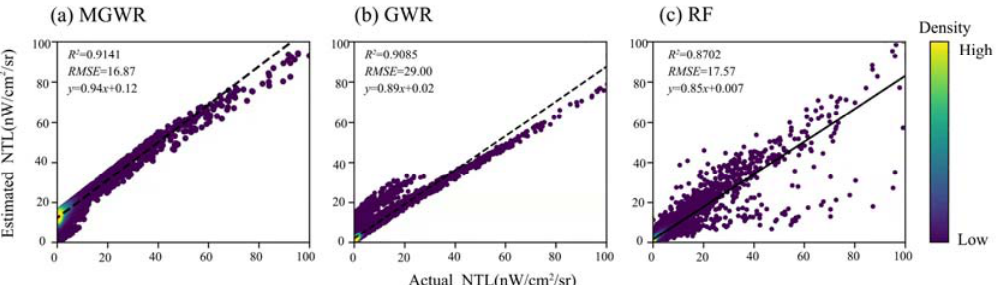
Figure 3. Scatter density plots between the estimated and actual NTL values for each pixel between ( a ) MGWR, ( b ) GWR, and the ( c ) RF regression. ( a ) MGWR, ( b ) GWR, and the ( c ) RF